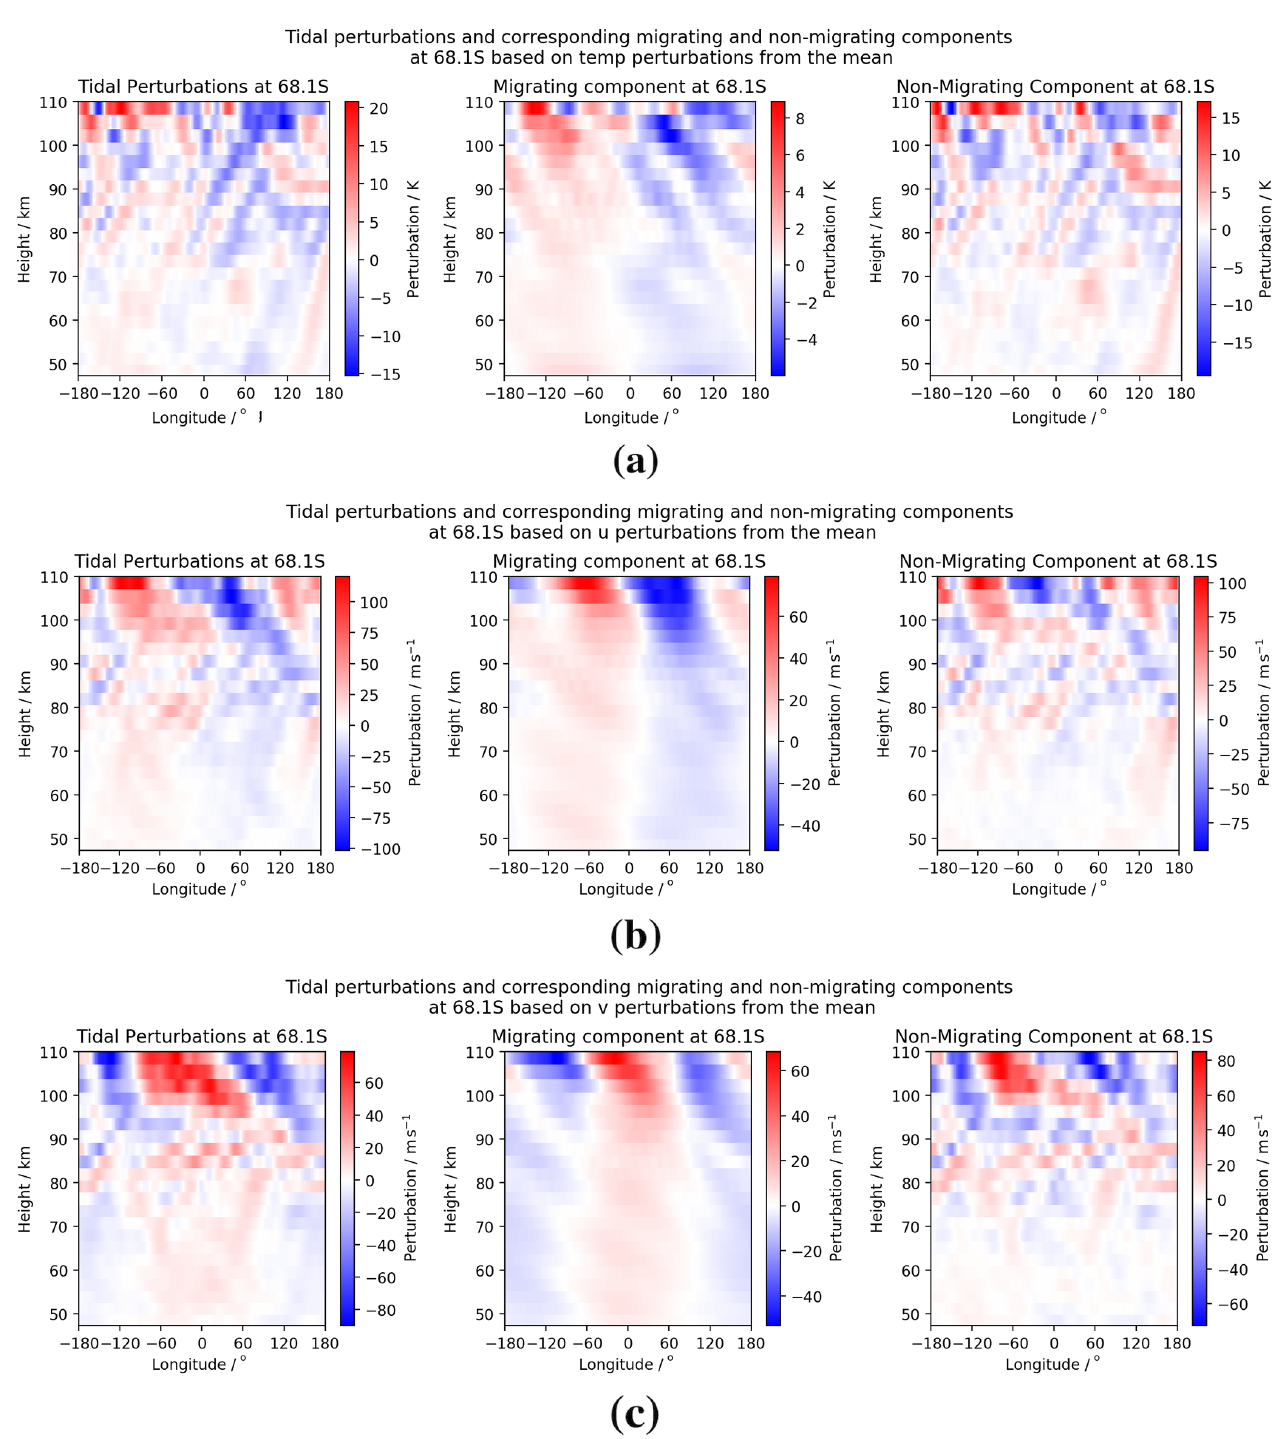
Figure 10. Longitude–height snapshot at 00:00UT on the first day of January at the polar latitude of Rothera (68 ◦ S) of tidal perturbations for (a) temperature, (b) zonal ( u ) winds, and (c) meridional ( v ) winds. The equatorial DW1 tide can be seen as the primary component of the migrating tide at lower altitudes, with a switch to a dominant SW2 component occurring around 95–100km in the wind fields and the temperature field becoming irregular. A superposition of several zonal wavenumbers is apparent in the non-migrating components.